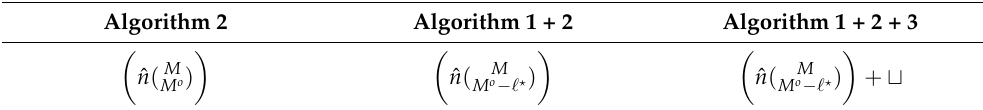
Table 1. Complexity level measurement of the algorithms. Algorithm 2 Algorithm 1 + 2 Algorithm 1 + 2 +